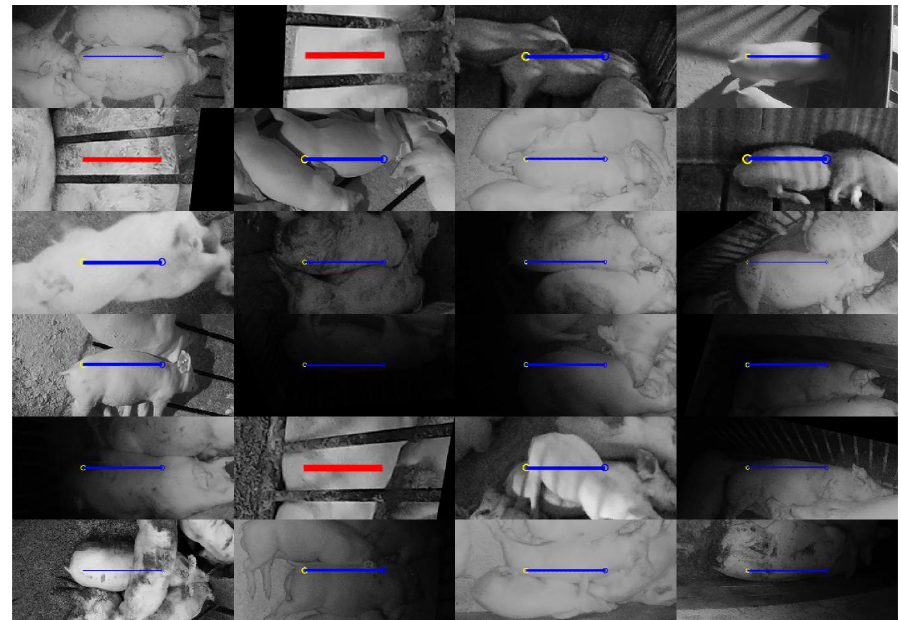
Figure 14. Twenty-four random samples of unsuccessful instance detections from the test:unseen set using the following color coding: false negative (blue), and false positive